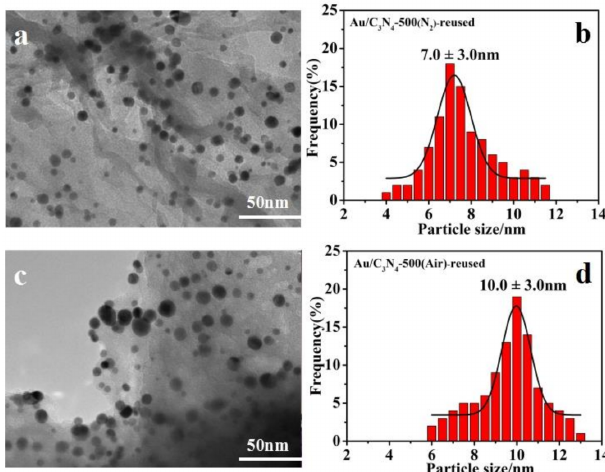
Figure 8. ( a ) TEM images and ( b ) particle-size distribution of Au/C 3 N 4 -500(N 2 )-reused; ( c ) TEM images and ( d ) particle-size distribution of Au/C 3 N 4